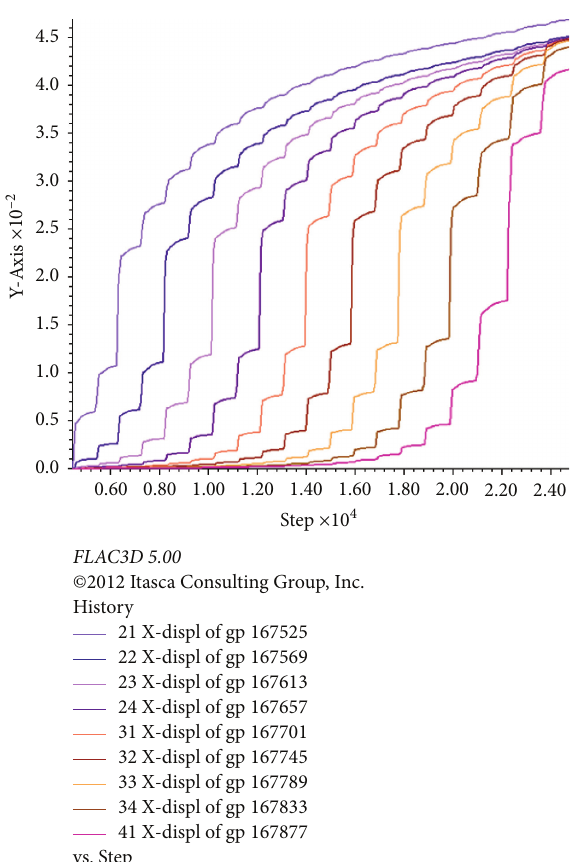
Figure 14: Horizontal displacement curve of the two sides of